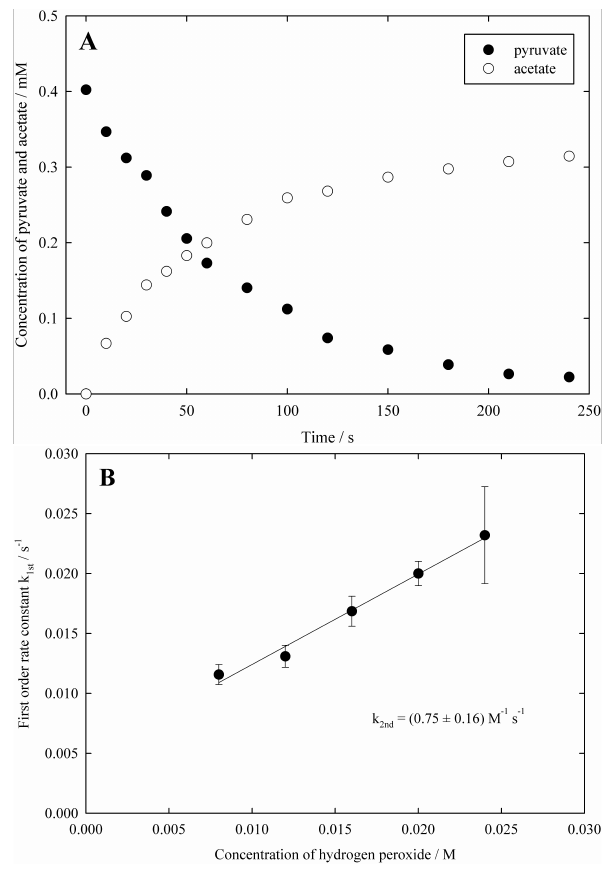
Fig. 5. (A) Concentration-time profiles of pyruvate and acetate dur- ing the reaction with H 2 O 2 at pH 7 for c(pyruvate)=0.4mM and c(H 2 O 2 )=12mM. (B) Pseudo-first order rate constants k 1st plotted over the concentration of hydrogen peroxide for the reaction with pyruvate at pH